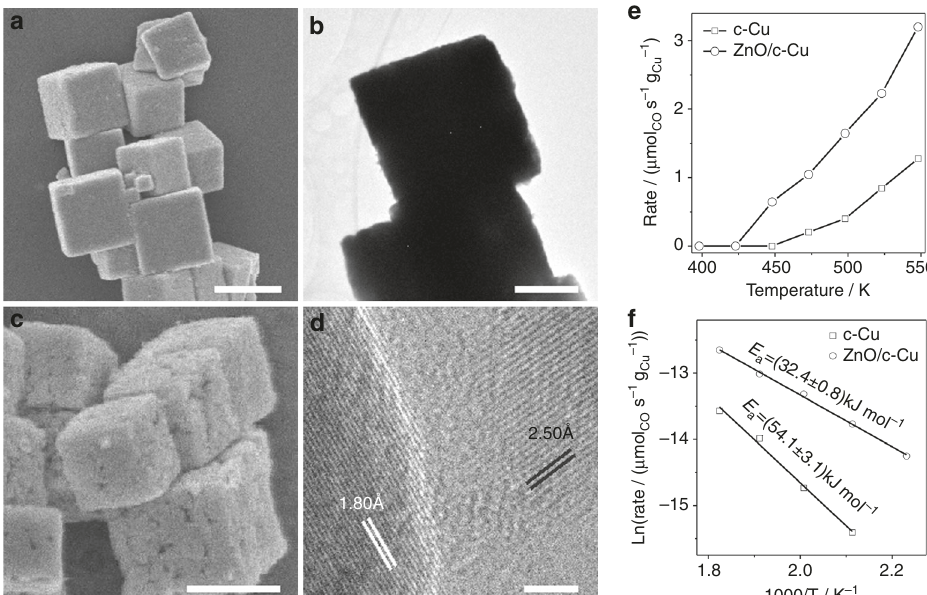
Fig. 7 ZnO/c-Cu catalyst. The scale bars of a , b correspond to 1000 nm, that of c correspond to 500 nm, and that of d correspond to 2 nm. a Representative SEM images of 1%wt-ZnO/c-Cu 2 O; b representative SEM, c TEM, d HRTEM images of 1.67%wt-ZnO/c-Cu catalysts; e Reaction rate ( μ mol CO s − 1 g Cu − 1 ) of 1.67%wt-ZnO/c-Cu catalyst in the WGS reaction as a function of reaction temperature and f Arrhenius plot of 1.67%wt-ZnO/c-Cu in the WGS reaction. The data of c-Cu NCs are included for comparisons. The data of c-Cu NCs are included for comparisons. The lattice fringes of 1.80 and 2.50 Å, respectively, correspond to the spacing of Cu{200} (JCPDS card NO. 89-2838) and hexagonal ZnO{101} (JCPDS card NO 89-1397) crystal